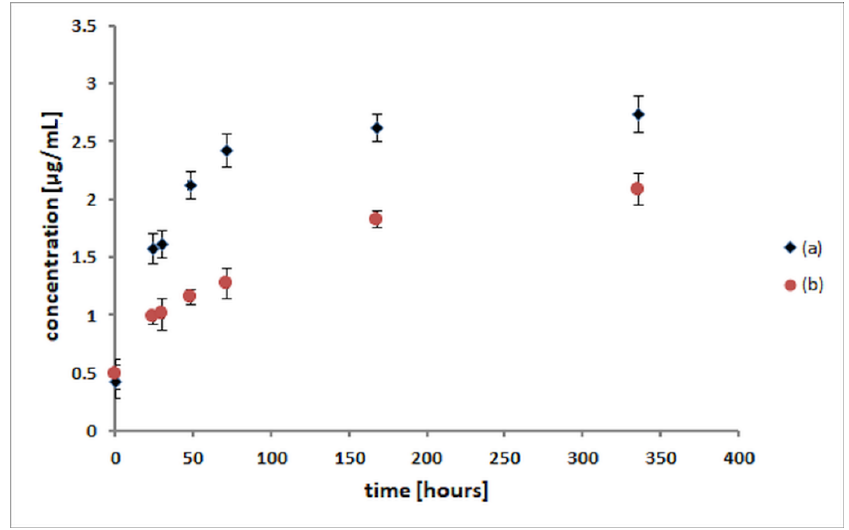
Figure 5. Comparative release profiles of p-anisic acid from (p-AA-CH 2 -HP) n homo(oligoester) ( a